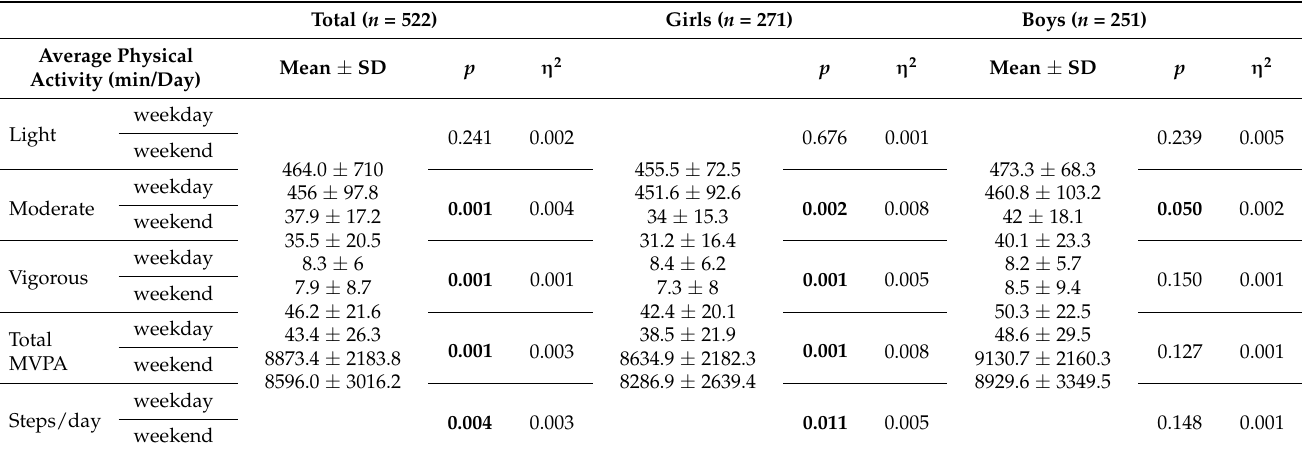
Table 2. Levels of physical activity in weekday and